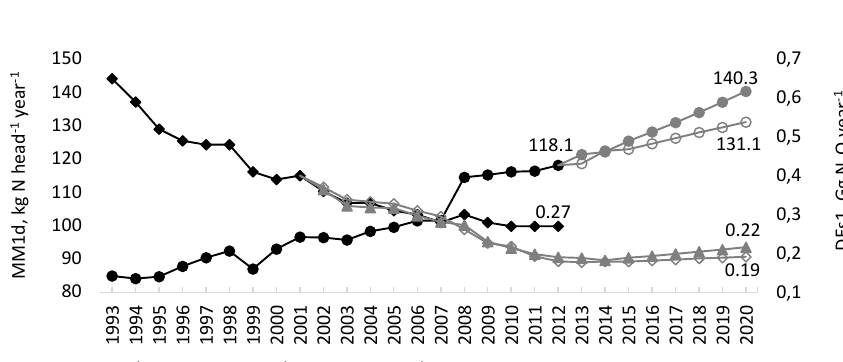
Fig. 7. Actual and projected nitrogen excretion factor (MM1d, kg N head -1 year -1 ) and N (DEs1, Gg N O year -1 ) from manure management in 1993 − 2020 (projections of the Estonian agricultural 2 model, Estonian NIR 2014, Estonian CRF